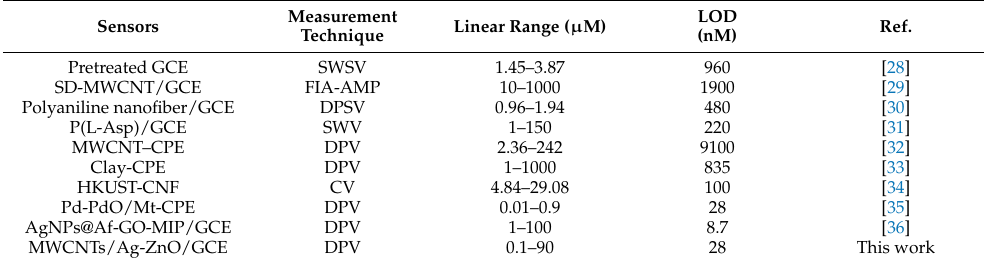
Table 1. Comparison of design sensors with reported sensors.